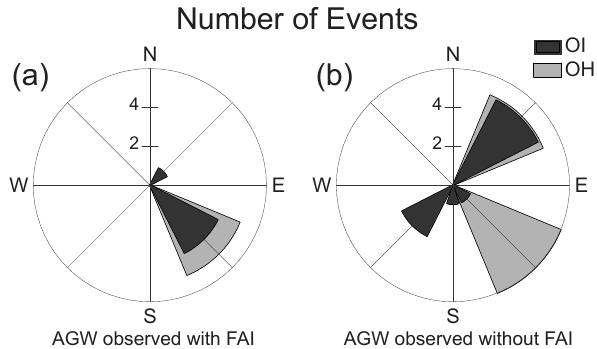
Fig. 3. Azimuthal distribution of AGW propagation direction ob- served at Nishino-Omote, Japan. All events were categorized into two types: (a) AGW simultaneously observed with FAI, (b) AGW observed without